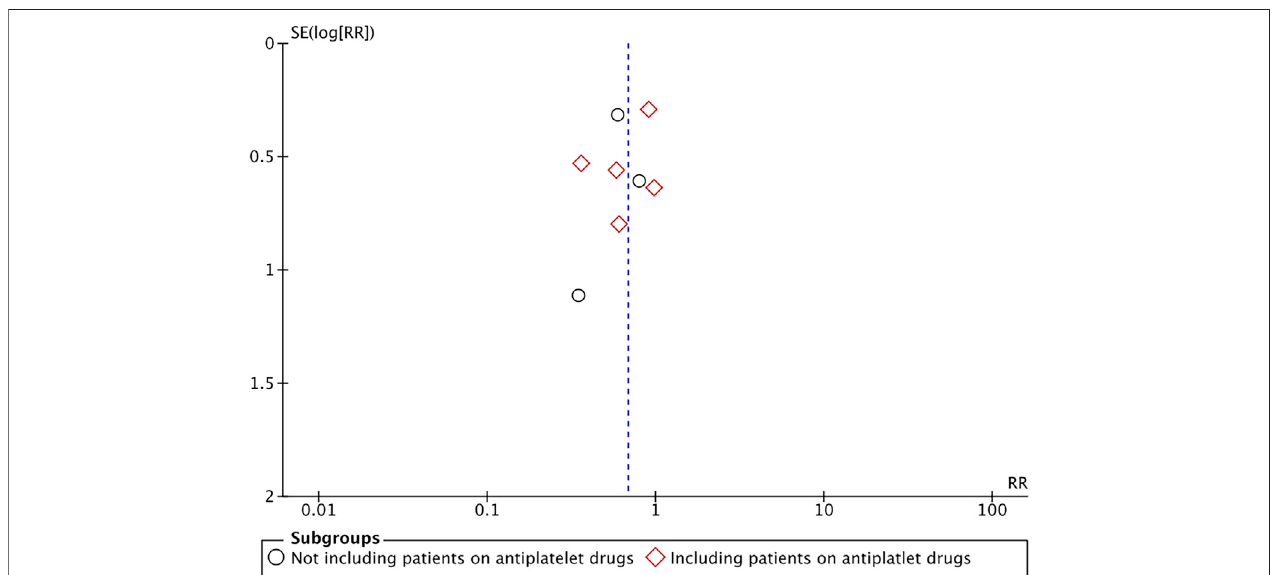
FIGURE 3 | Funnel plot for assessing publication bias.